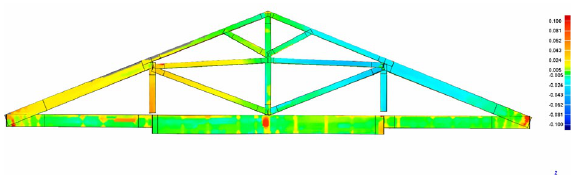
Figure 14: Three-dimensional representation of the displacement observed by overlapping the ideal 3D model and the point cloud of a single truss.